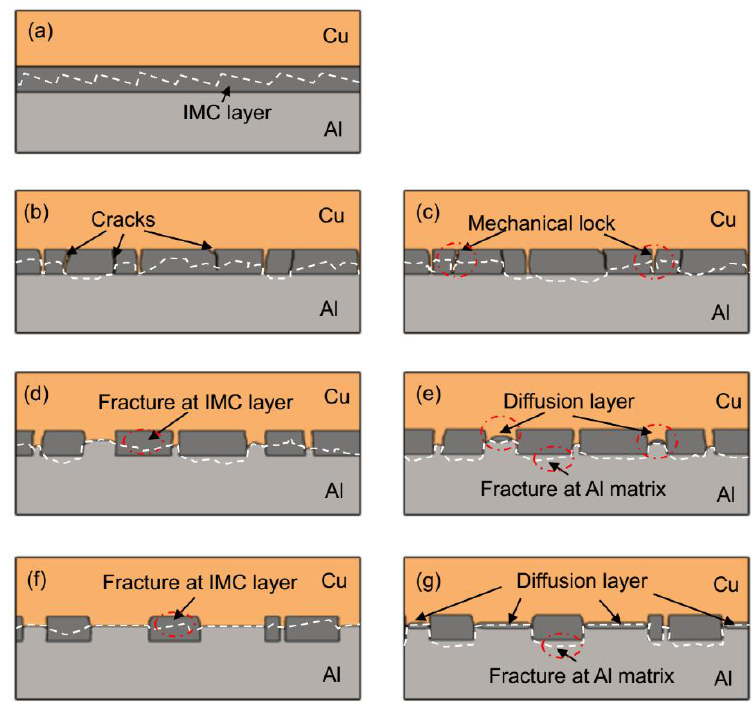
Figure 13. The schematic diagram of the bonding mechanism of Cu/Al clad sheets for rolling and annealing processes. ( a ) as-cast, ( b ) thickness of 7 mm after rolling, ( c ) thickness of 7 mm after rolling and annealing, ( d ) thickness of 5 mm after rolling, ( e ) thickness of 5 mm after rolling and annealing, ( f ) thickness of 3 mm after rolling, and ( g ) thickness of 3 mm after rolling and annealing.